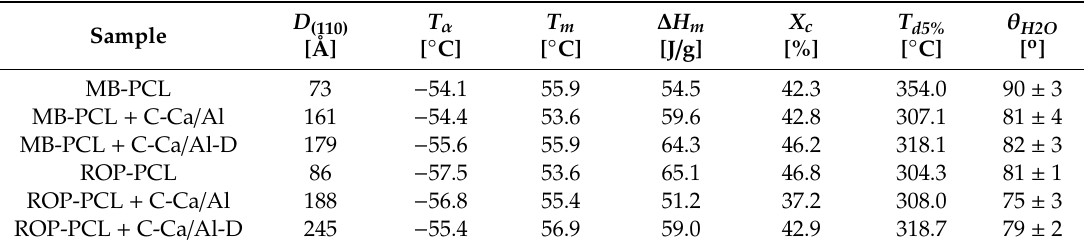
Table 2. Crystalline domain sizes, thermal behavior, water contact angle of PCL-LDH nanocomposite and neat PCL films.